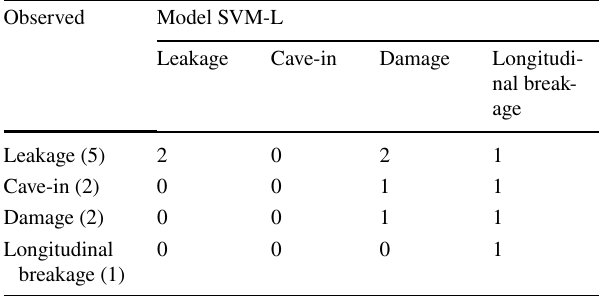
Table 7 Classification of sewer laterals’ damages—model SVM-L, testing set